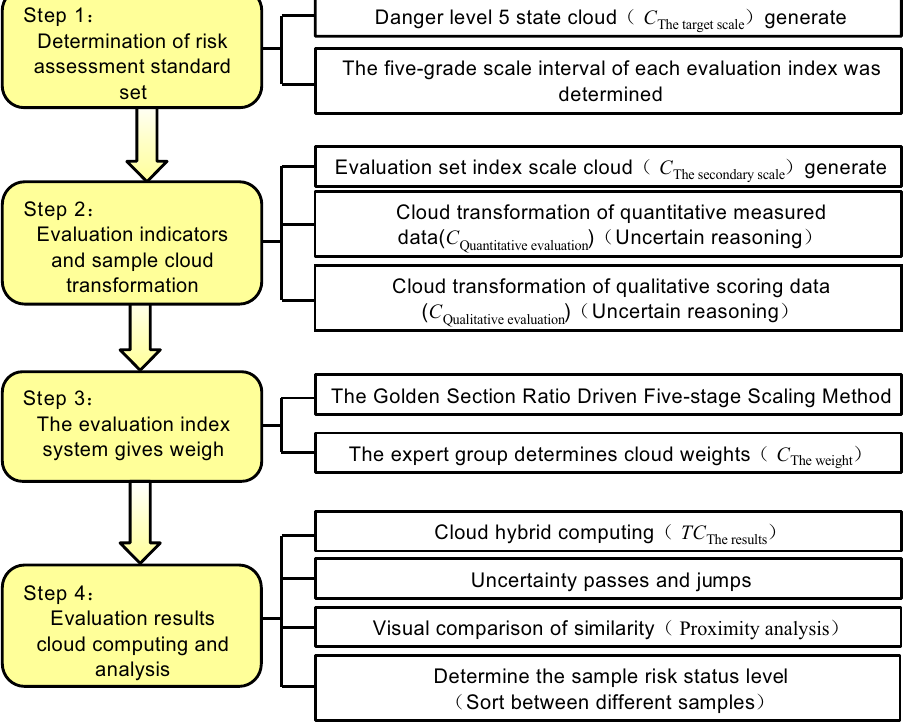
Figure 2. Flow chart of risk assessment based on cloud theory.